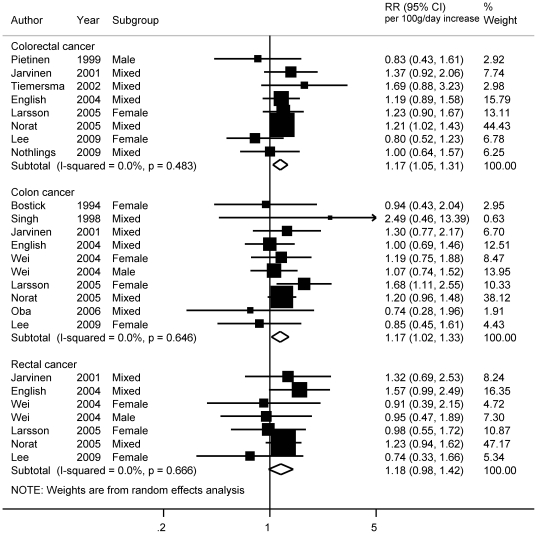
Dose-response meta-analyses of red meat consumption and the risk of colorectal, colon and rectal cancers.References: Pietinen, 1999 [57]; Jarvinen, 2001 [61]; Tiemersma, 2002 [63]; English, 2004 [60]; Larsson, 2005 [34]; Norat, 2005 [50]; Lee, 2009 [25]; Nothlings, 2009 [26]; Bostick, 1994 [52]; Singh, 1998 [53]; Wei, 2004 [18]; Oba, 2006 [27]